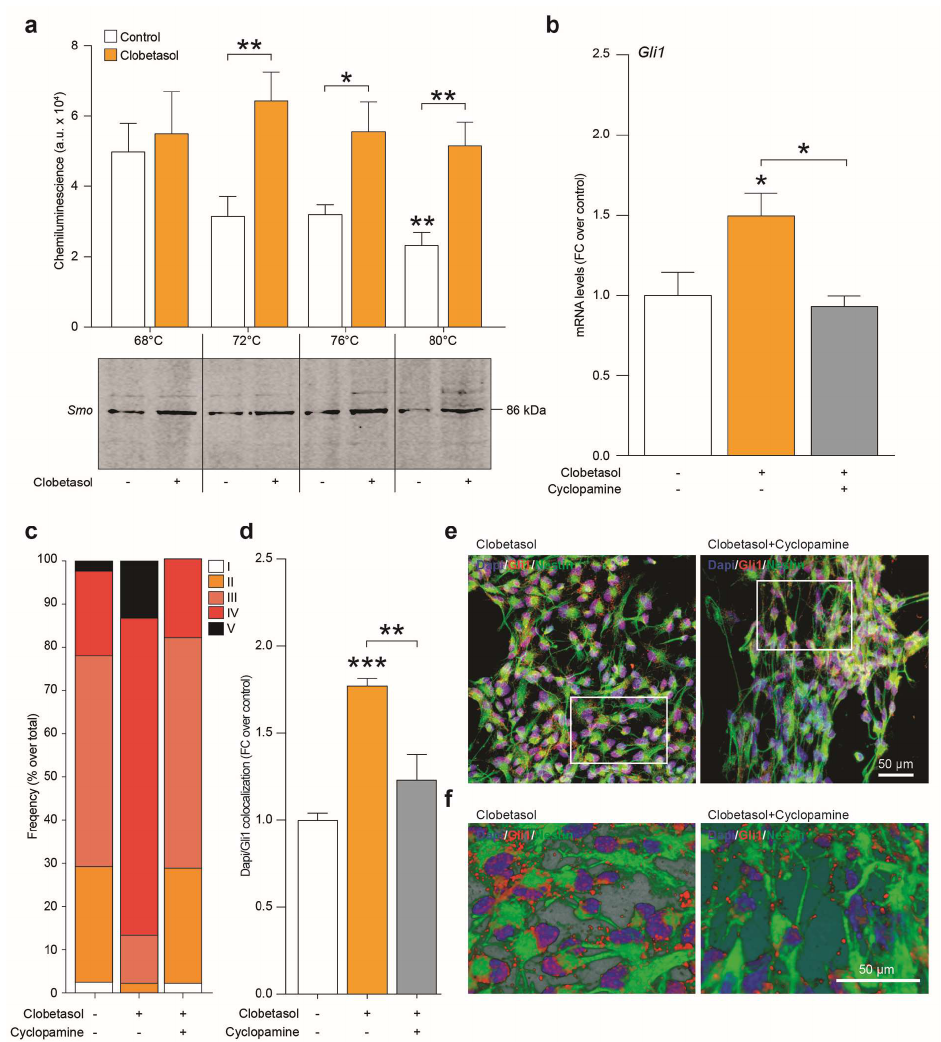
Figure 6. Clobetasol targets Smo activating canonical Shh signaling within NSCs. ( a ) Cellular thermal shift assay for target engagement with Smo. Clobetasol was subjected to cellular thermal shift assay (CETSA) at 4 di ff erent temperatures from 68 to 80 ◦ C. Quantification and representative blot of target engagement. Data are means of n = 3 independent experiments. * p -value < 0.05, ** p -value < 0.01, *** p -value < 0.001 vs. control or between groups. ( b ) mRNA levels of Gli1 in NSCs exposed to clobetasol, cyclopamine or clobetasol plus cyclopamine. Data are mean fold change over control ( ± SEM) of n = 3 independent replicates. ( c ) Quantification of the intensity range (I and II = low; III = medium; IV and V = high) frequency of Dapi / Gli1 colocalization in control NSCs and NSCs exposed to clobetasol, cyclopamine or clobetasol plus cyclopamine. ( d – f ) Quantification of Dapi / Gli1 colocalization (d); representative confocal pictures ( e ) and 3D deconvolutions ( f ) of Gli1 and Nestin in control NSCs and NSCs exposed to clobetasol, cyclopamine or clobetasol plus